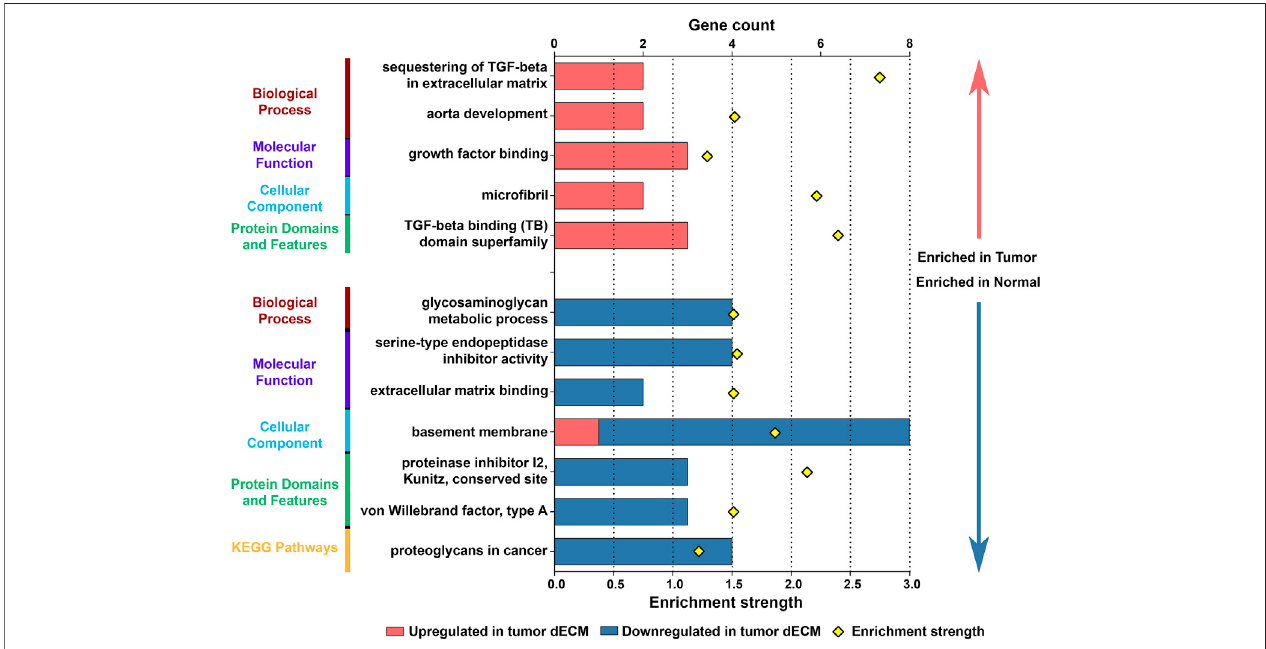
FIGURE 3 | Functional and pathway enrichment analysis of differentially expressed proteins in tumor ECM. For GO term analysis, proteins were assigned to three main categories: Biological Process, Molecular Function and Cellular Component. The main Protein Domains and Features and KEGG Pathways were also identi fi ed. Graphdepicts themost relevant results foreach category enriched intumor and normal ECM(additionaldata in Supplementary Table S2 ).Barsrepresentgenecount and dots depict enrichment